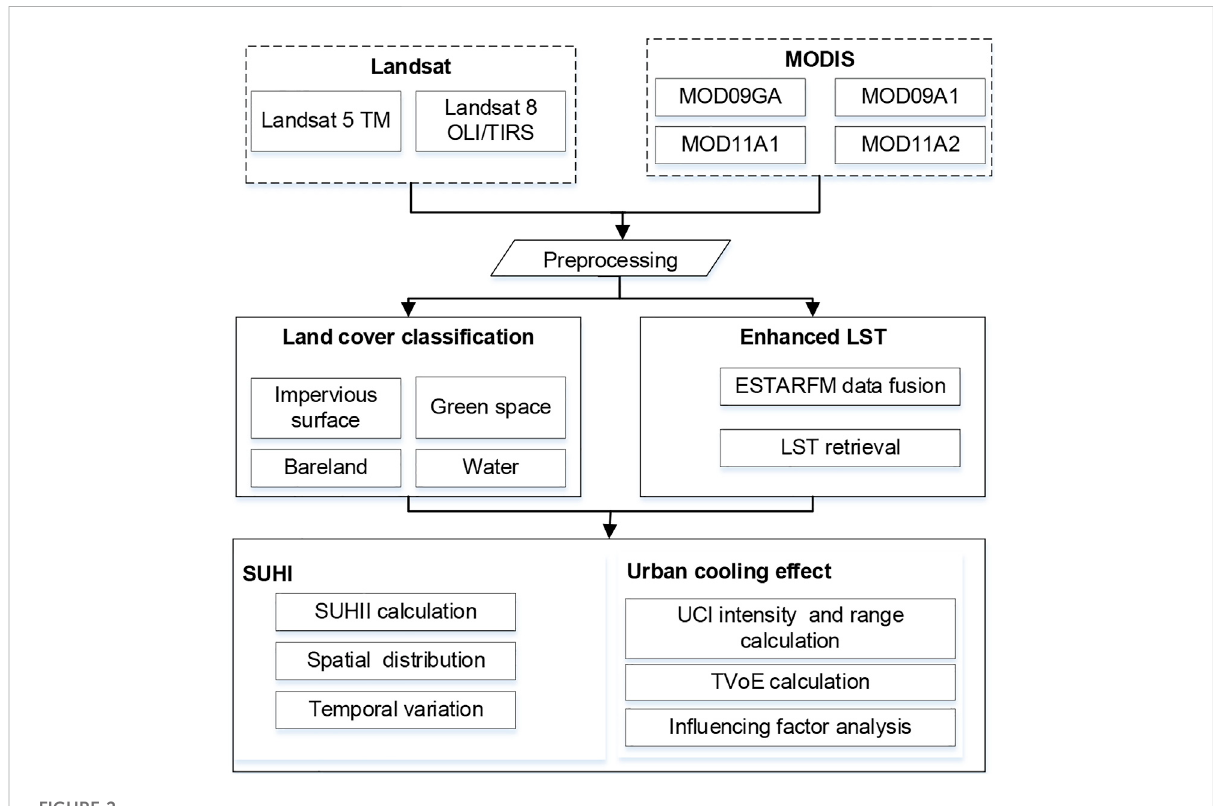
FIGURE 2 The data processing work fl ow.